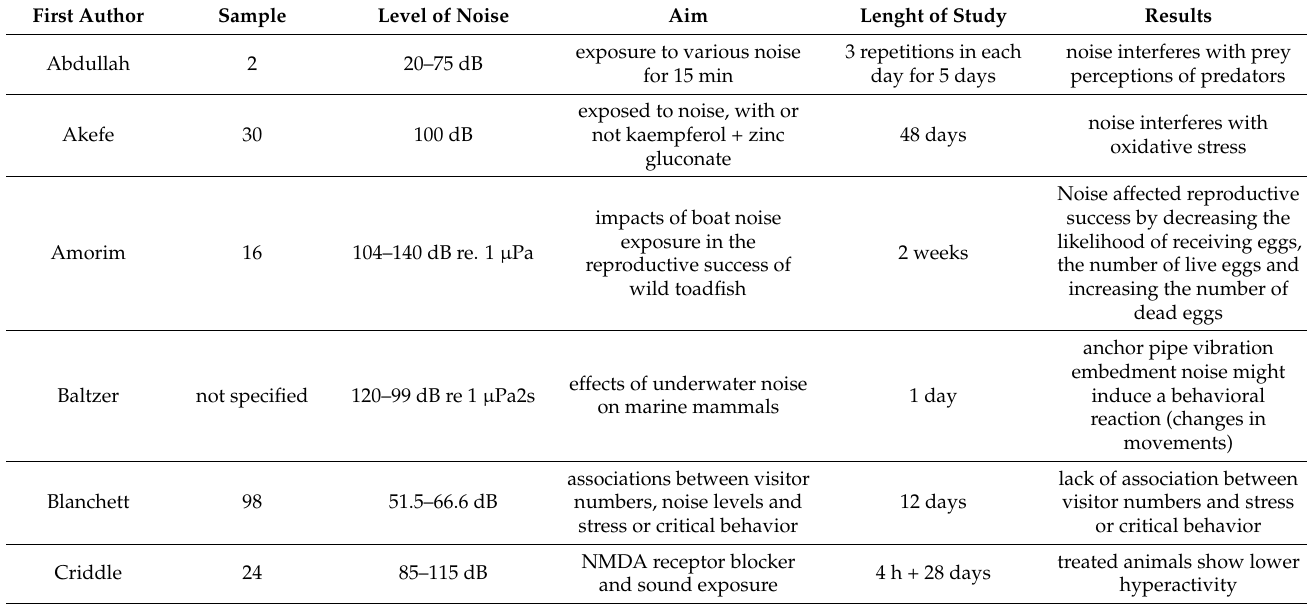
Table 4. Cohort, case-control, experimental and observational studies included in this